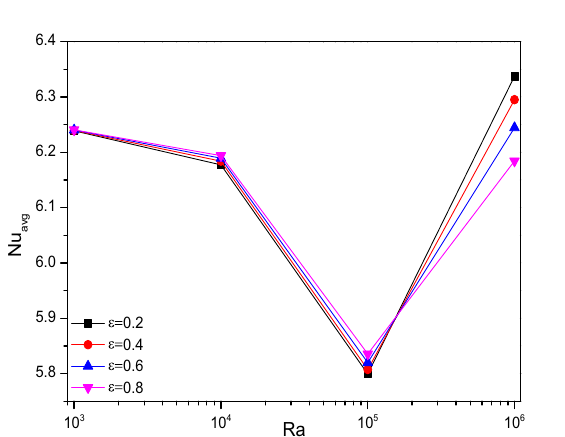
Figure 5. Variations of Nu avg with Ra for diverse Da when Ha = 0 , φ = 0.02 , ω = 0 , N = 4 , r = 0.1, and ε = 0.2 .